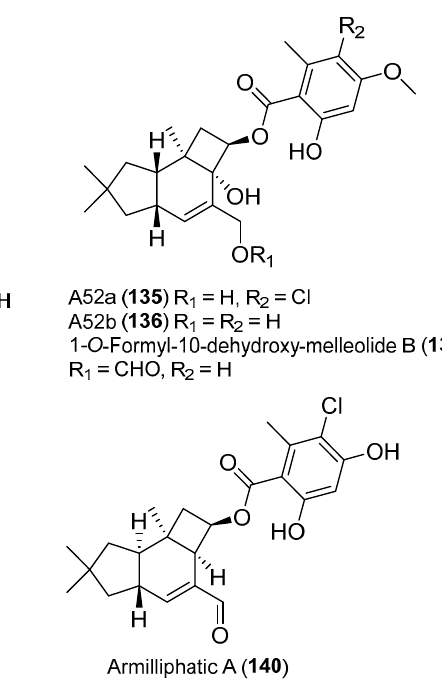
Figure 21. Structures of Δ 2,3 -protoilludene-containing aryl sesquiterpenoids 134 – 141 isolated from the Armillaria genus of fungi.